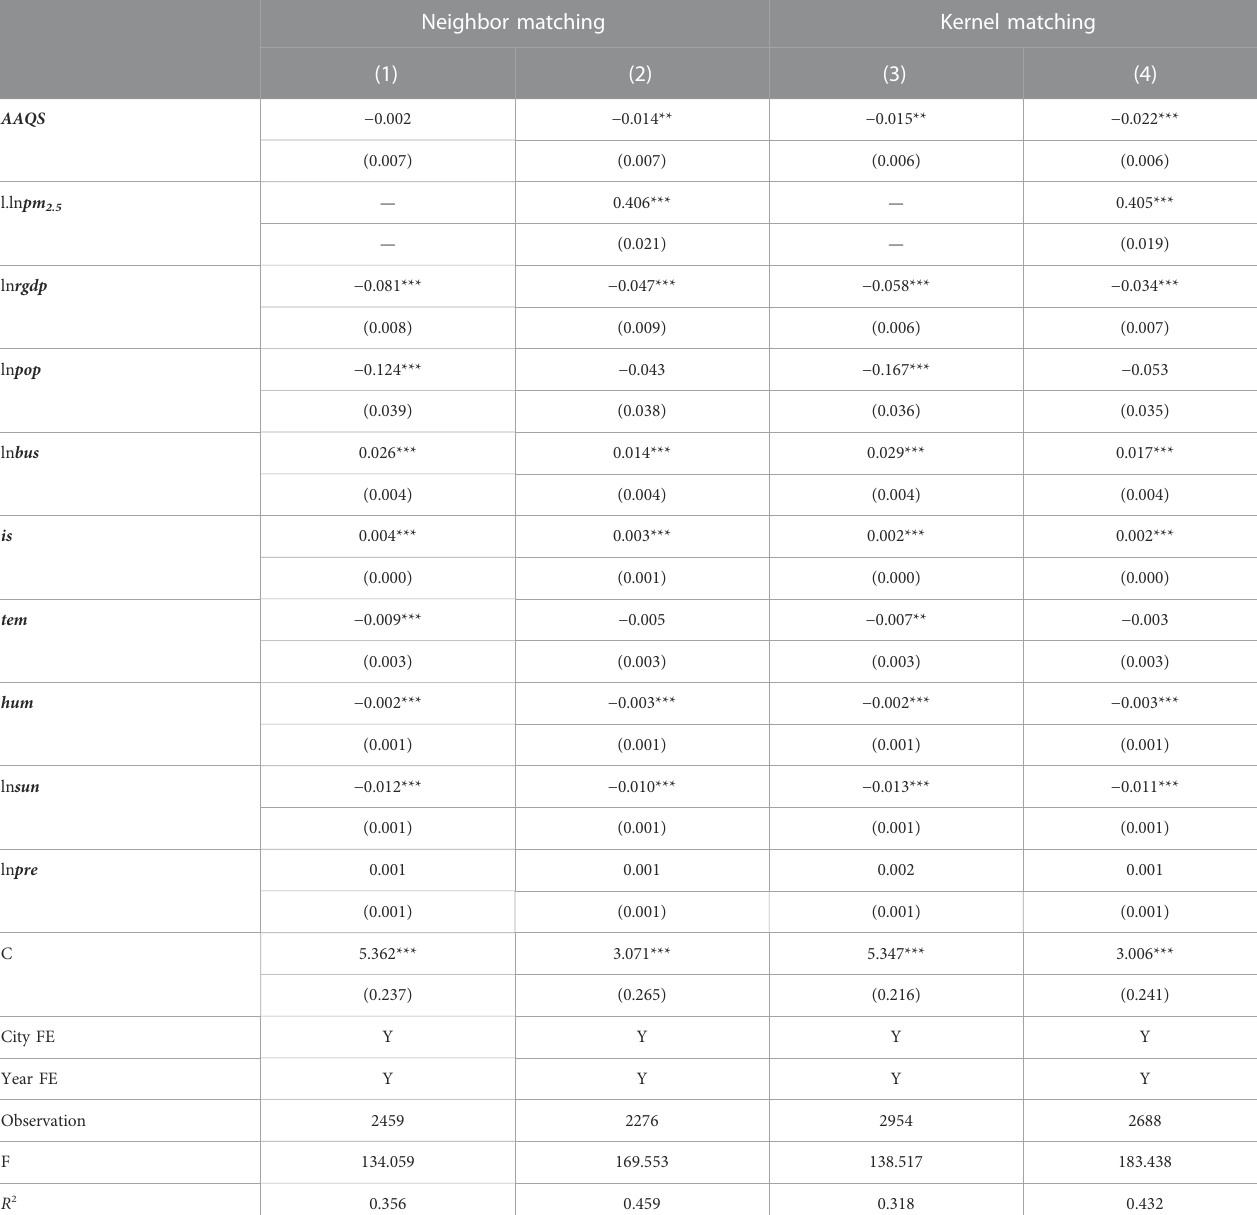
TABLE 8 Re-estimation based on PSM-DID. Neighbor matching Kernel